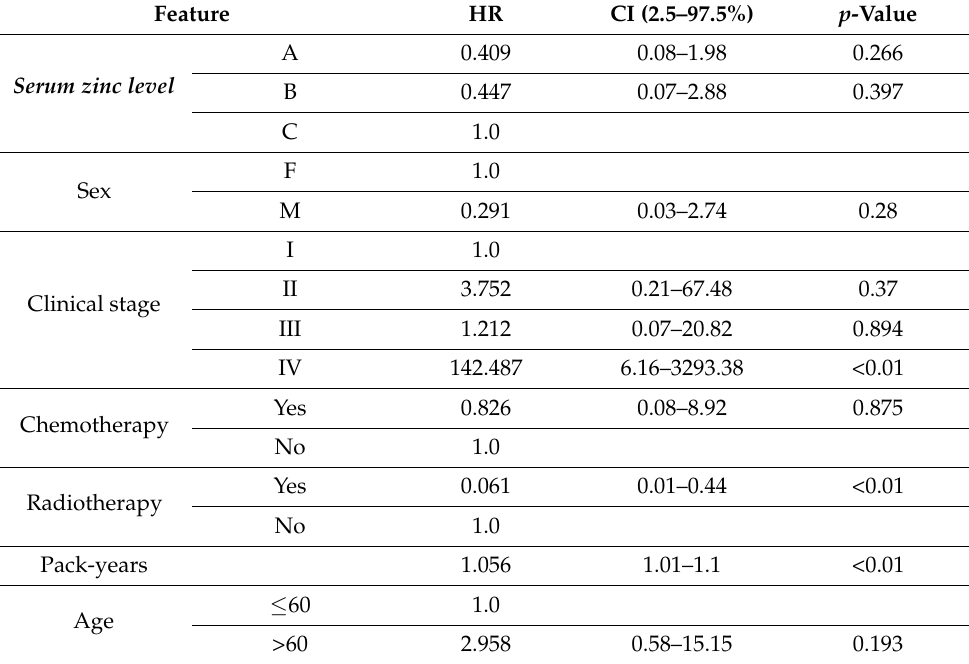
Table 9. Multivariable Cox regression (without SOD2 TC/TT and without CAT CC , n = 40).